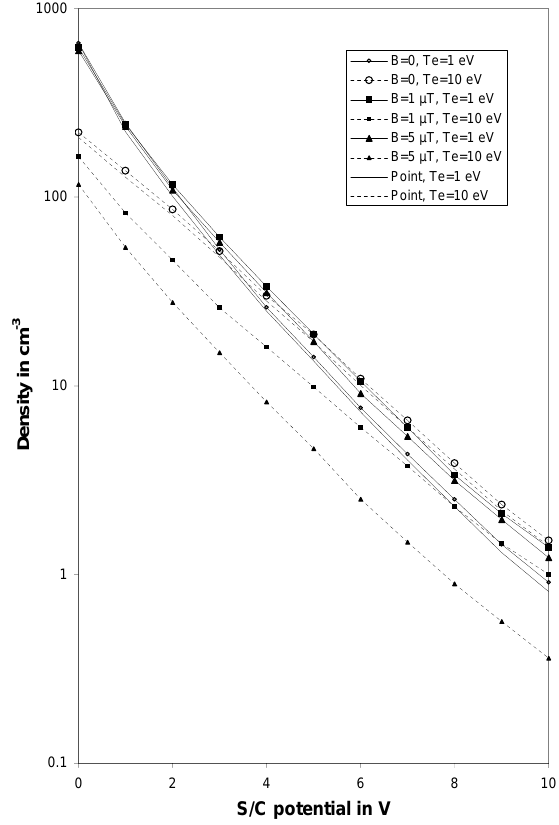
Fig. 8. Relations between the floating spacecraft potential and the plasma density N e (8 s ) for B 0 = 0 (circles), B 0 = 1 µ T (squares) and B 0 = 5 µ T (triangles). The solid and dashed fitted curves cor- responding to T e = 1eV and T e = 10eV, respectively.